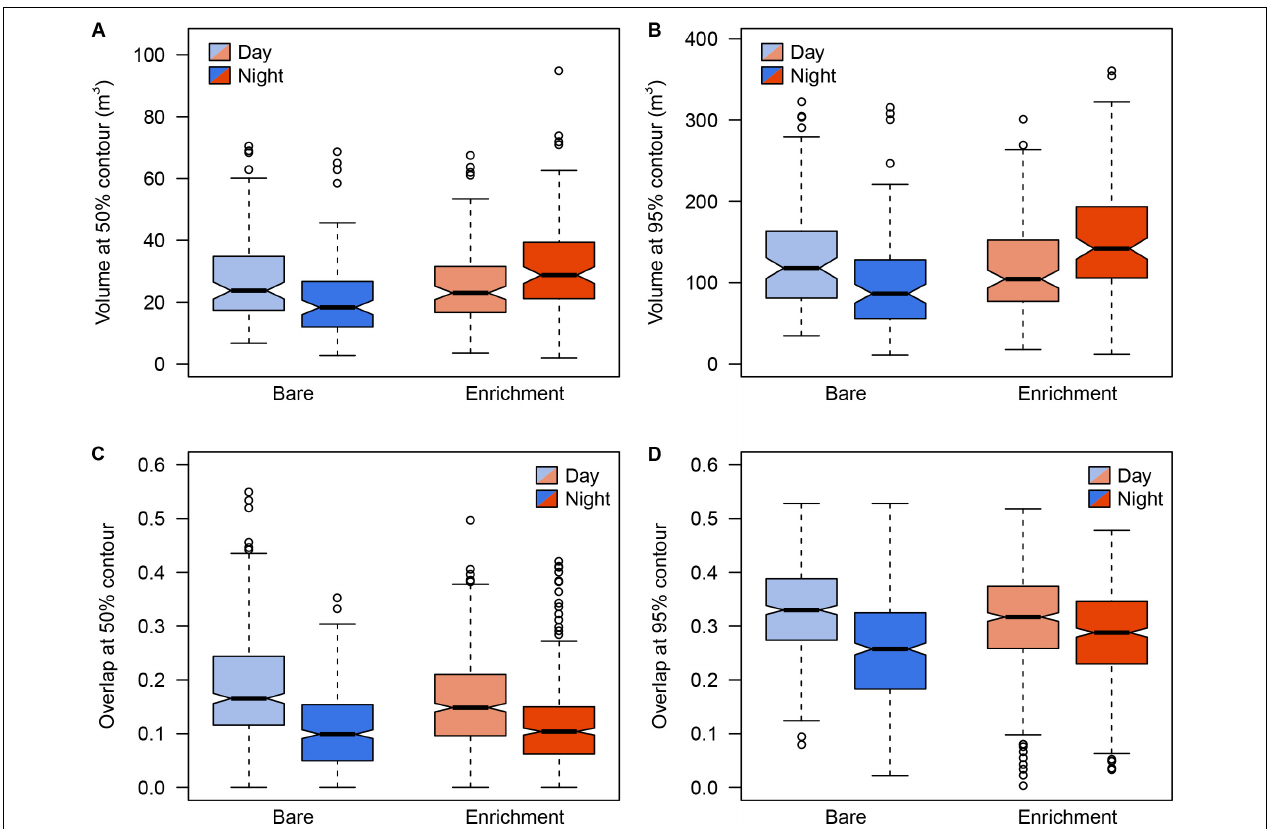
FIGURE 4 | Distribution of volume sizes and volumes in 50 and 95% over the time, day and night, in the bare period (blue) and enrichment period (orange). Boxes represent the interquartile range and the inside bar is the median. The lines extend to the values at 1.5 times the interquartile range, while the open circles represent potential